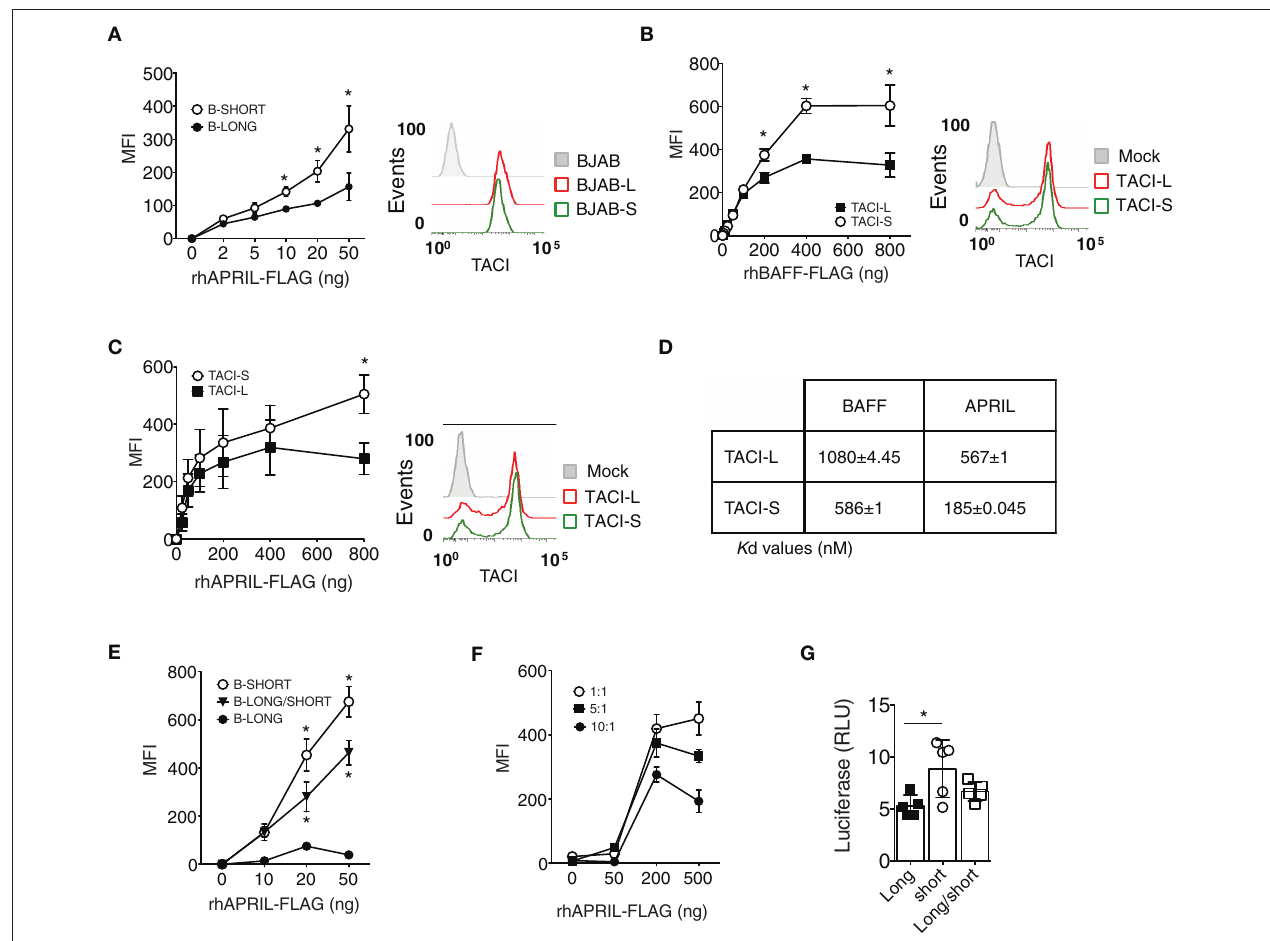
FIGURE 4 | TACI-S display increased ligand binding. (A) To compare ligand binding capacities of isoforms, varying concentrations of FLAG-APRIL (0–50ng/ml) were incubated with TACI-L or TACI-S transduced BJAB cells. Ligand binding was determined by FACS (LSRII) on washed cells, after incubation with anti-FLAG-PE. Comparable expression of TACI was determined by FACS (LSRII) using GFP expression. (B,C) To compare ligand binding in TACI-L or TACI-S transfected HEK-293T cells, cells were incubated with increasing amounts (0-800 ng) of either FLAG-BAFF (B) or FLAG-APRIL (C) . Comparable expression of TACI isoforms in each case was determined by FACS (LSRII) using anti-TACI antibody. (D) The binding affinity of TACI-L and TACI-S to ligands BAFF and APRIL was determined by Microscale thermophoresis (MST). The change in the thermophoretic signal produces these K d values (nM). Data represent the mean and SD of three independent thermophoresis measurements. (E) BJAB cells transduced with TACI-S and TACI-L, displayed binding of FLAG-APRIL intermediate between the TACI-S and TACI-L. (F) Diminishing ligand binding was also found for TACI-S HEK-293T cells also transfected with increasing ratios of TACI-L (ratios 1:1, 5:1, or 10:1) and incubated with to 0–500 ng of FLAG-APRIL. (G) HEK-293T cells transfected with both TACI-S and TACI-L, demonstrated intermediate NF-kB luciferase induction as compared to cells with either isoform. Values reported are represented as Mean of Fluorescence Intensity (MFI) (A-C,E,F) and as Relative Luciferase Units (RLU) (G) and are the mean ± SEM from 5 to 7 independent experiments. * p < 0.05, two-tailed paired Student t -test.